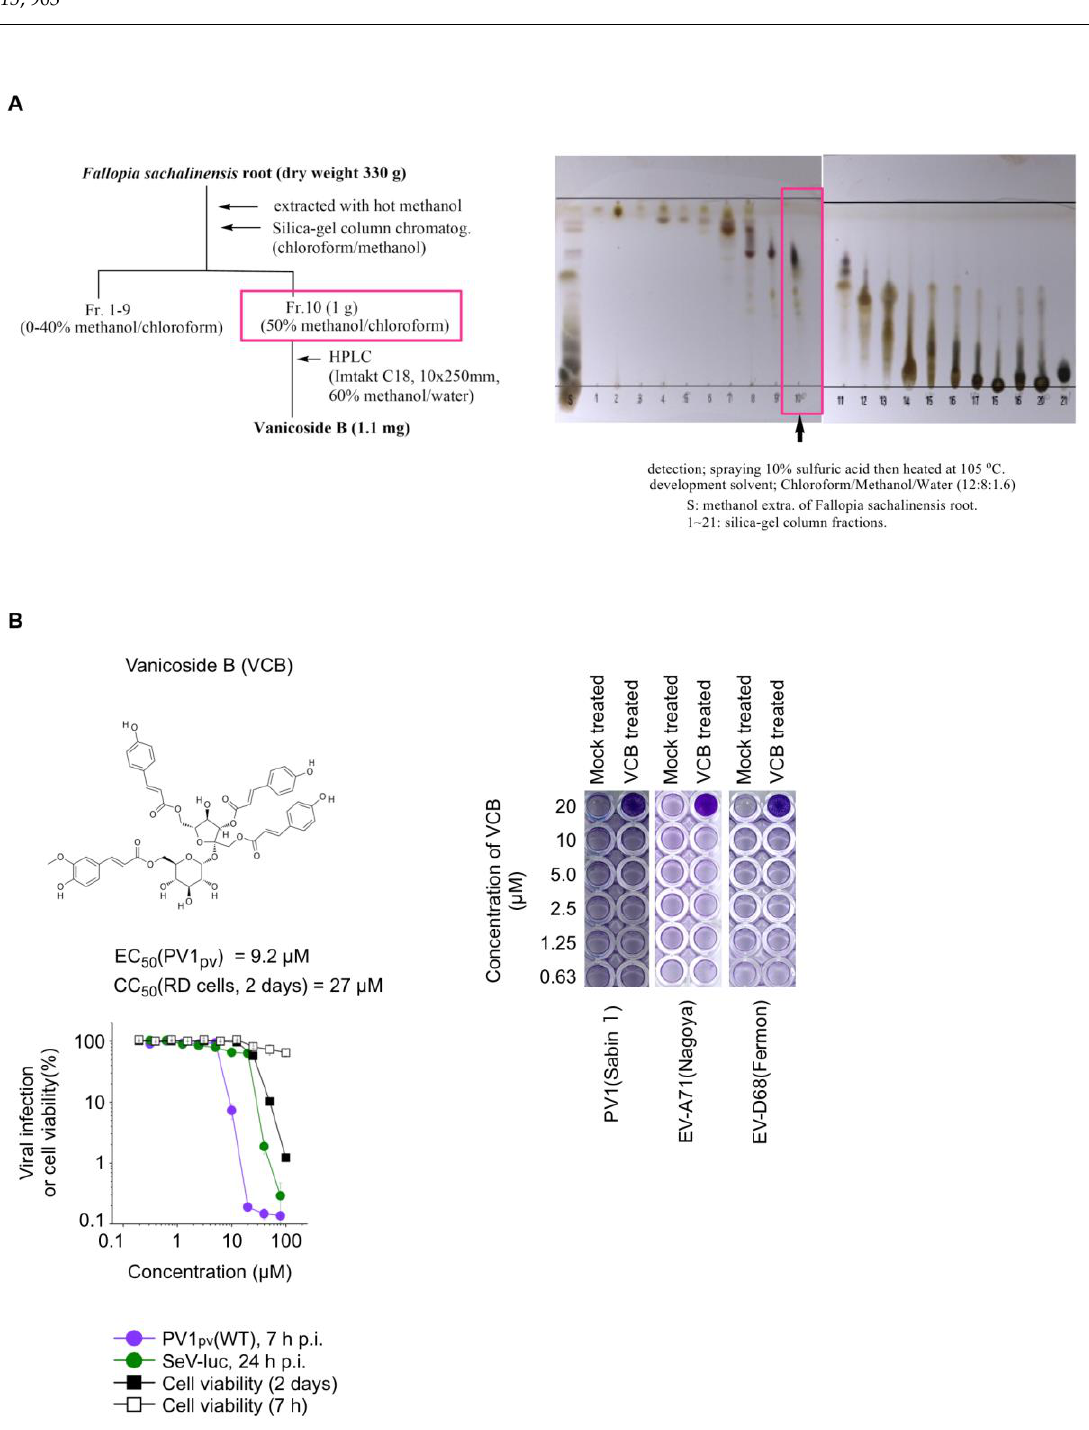
Figure 3. Identification and purification of an anti-PV compound from F. sachalinensis extract. ( A ) Procedure of purification of anti-PV compound from F. sachalinensis root extract. Boxes highlight the fraction containing vanicoside B. ( B ) Antiviral effect of VCB on PV infection. (Left) Structure of VCB, cytotoxicity, and antiviral activity of VCB. Viral infection and viability of RD cells in the presence of VCB are shown. RD cells were infected with PV1 pv or SeV-luc, then luciferase activity was measured at 7 h p.i. (for PV1 pv ) or 24 h p.i. (for SeV-luc). Viral infection or the cell viability in the absence of VCB were taken as 100%. (Right) Antiviral effect of VCB on EV infection. RD cells on 96-well plates were infected with EV at an MOI of 0.005 (for PV), 0.05 (for EV-A71) or 0.5 (for EV-D68) in the absence (mock-treated) or the presence (VCB treated) of VCB at the indicated final concentration. The cells were fixed and stained at 2 days p.i. (for PV) or 4 days p.i. (for EV-A71 and EV-D68). The data are representative of two independent experiments with two to three biological replicates.